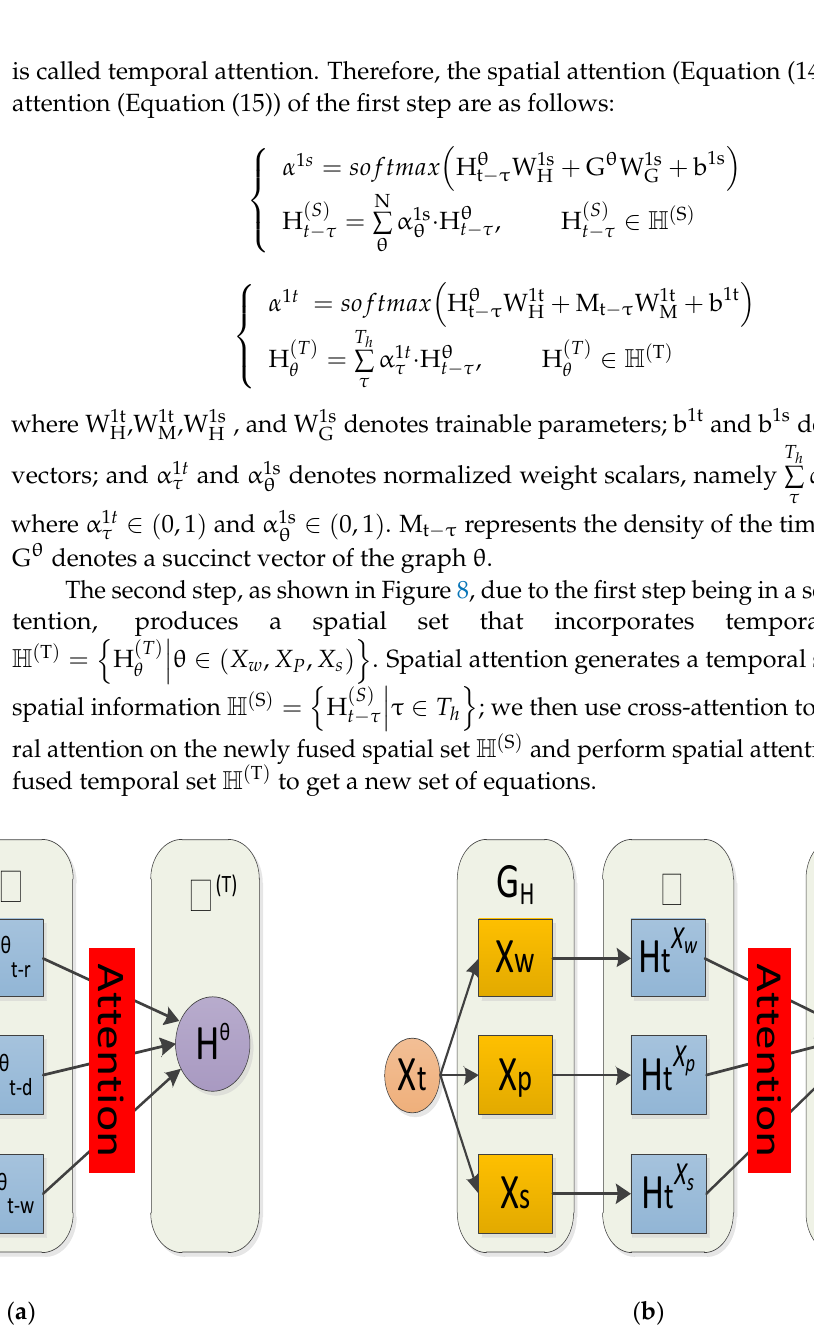
Figure 8. First step cross attention. ( a ) Time series: Temporal Fusion. ( b ) Multi-Graph: Spatial Fusion.